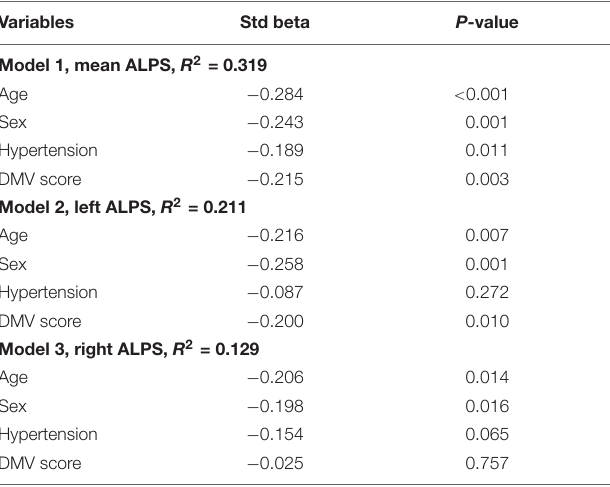
TABLE 2 | Regression analyses